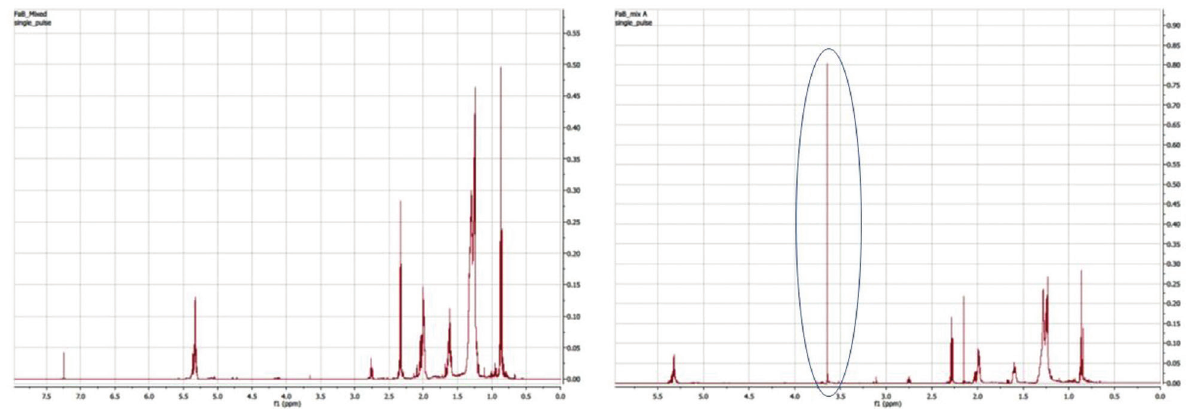
Figure 2: 1 H NMR of MIX pre and post esterification. The methyl ester peak is highlighted.